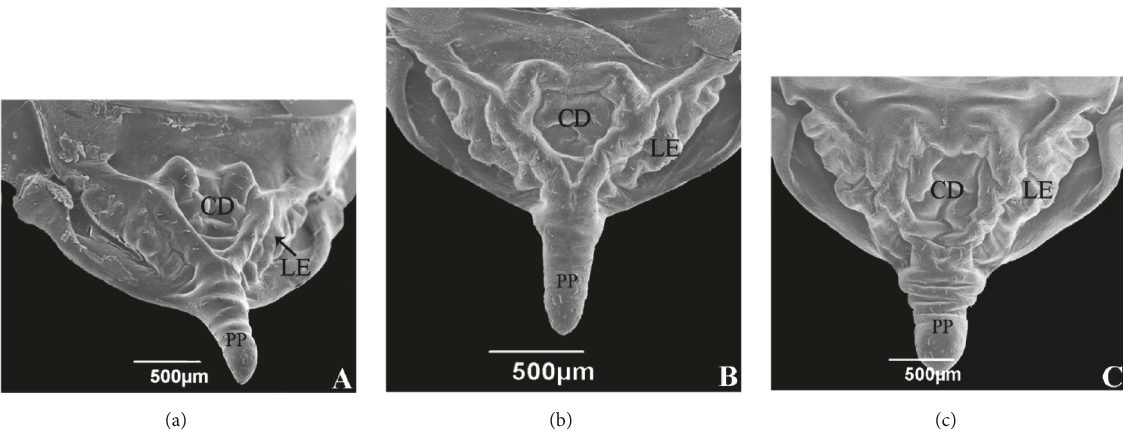
Figure 4: Micrography of the scutellum female. (a) Triatoma carcavalloi. (b) Triatoma circummaculata . (c) Triatoma rubrovaria . CD: central depression. LE: lateral edges. PP: posterior process of scutellum.